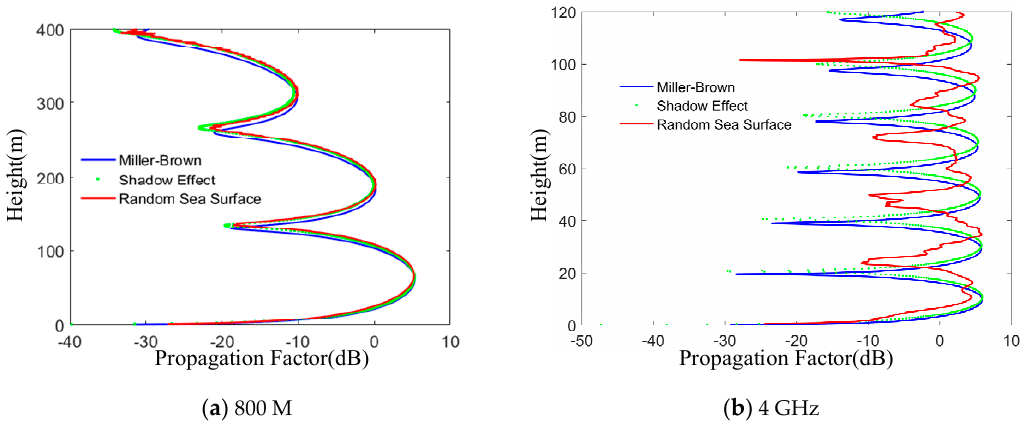
Figure 15. The frequency effects on different methods. The two examples ( a ) 800 M and ( b ) 4 GHz, show propagation factors of random sea surface model, Miller-Brown model and shadow effect at different frequencies.